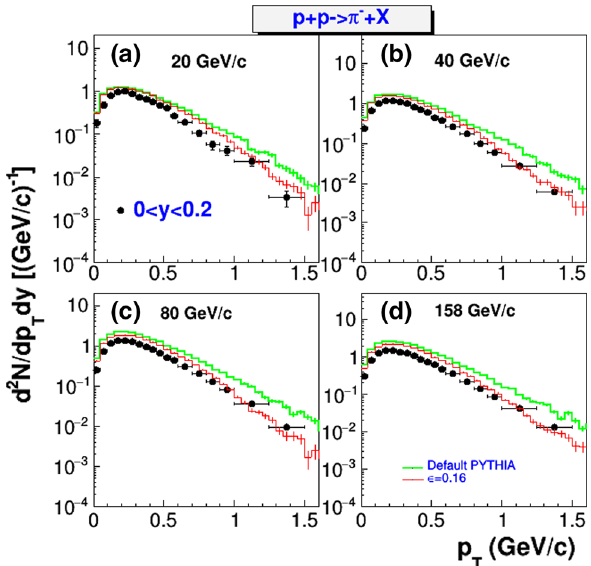
Fig. 1 Transverse momentum specta of π − in inelastic pp collisions at beam momentum of 20, 40, 80 and 158 GeV/c. The thick and thin lines denote the default PYTHIA8.303 and Gaussian p T settings of Table 1, respectively. The closed points represent NA61/SHINE [9]